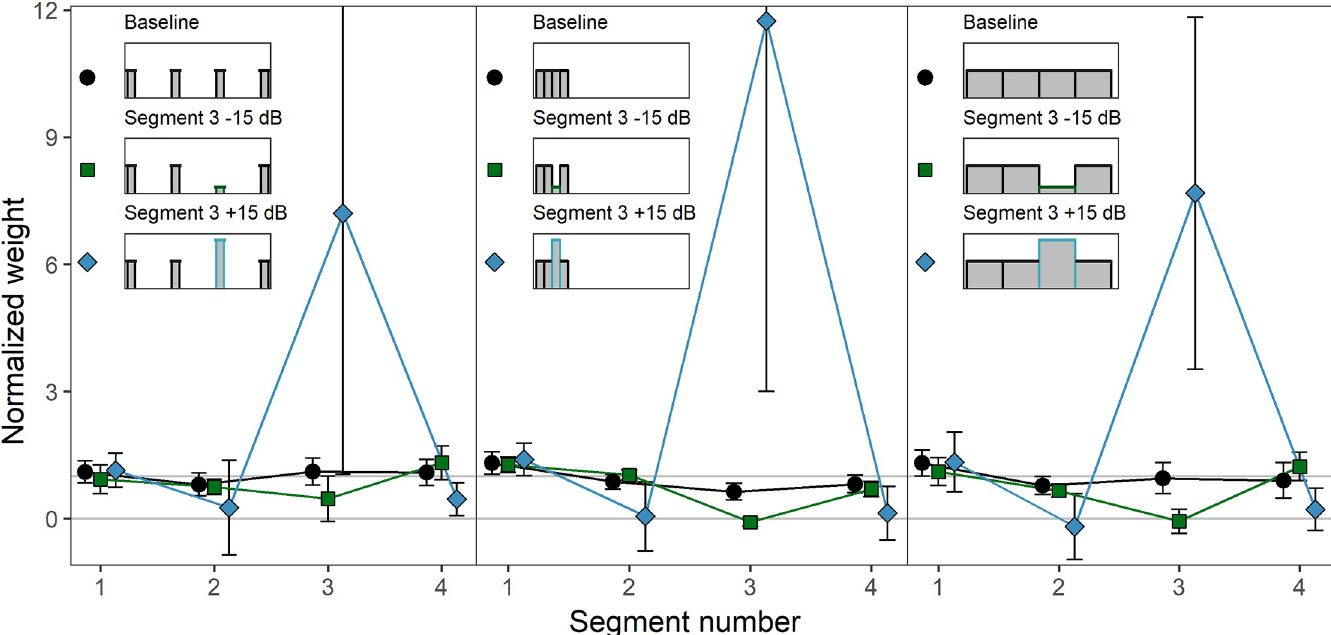
Fig 6. Experiment 3. Mean normalized weights as a function of segment number for the three sound types. Left panel: 100-ms segments with 500-ms gaps. Middle panel: 100-ms contiguous segments. Right panel: 475-ms contiguous segments. Black circles: Baseline condition. Dark green squares: Attenuation of segment 3 by 15 dB. Blue-gray diamonds: Amplification of segment 3 by 15 dB. Error bars show 95% confidence intervals (CIs).